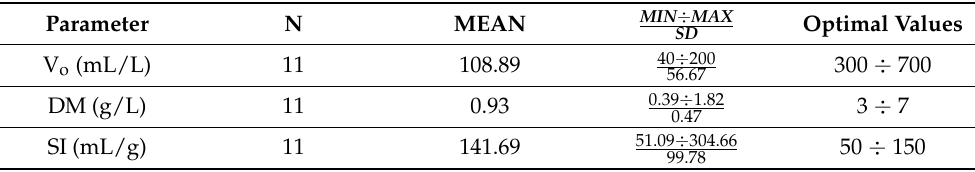
Table 6. Characteristic of tested activated